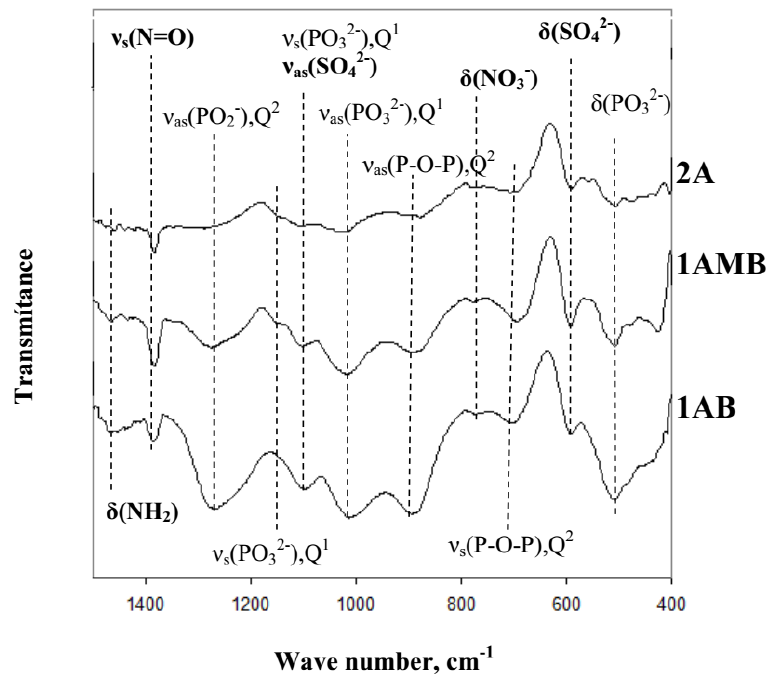
Figure 4. FT-IR spectra of the materials 1A, 2AB, and